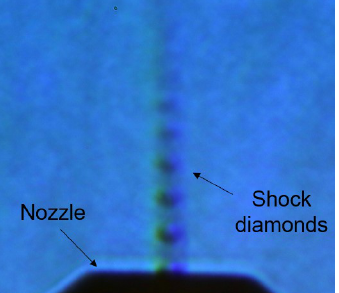
Figure 9. The obtained image with our Schlieren imaging system. Supersonic jet with shock diamonds are shown.